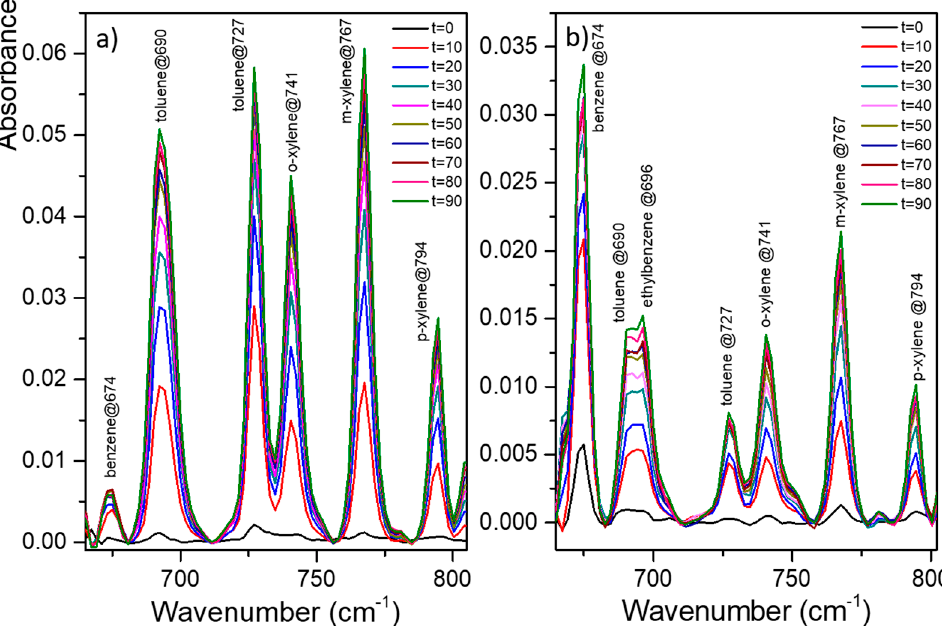
Figure 7. MIR-ATR absorption spectra of groundwater sampled in Piezometer 1 ( a ) and in Piezometer 2 ( b ) for different time enrichment (from 0 to 90 min) using a PIB coating.